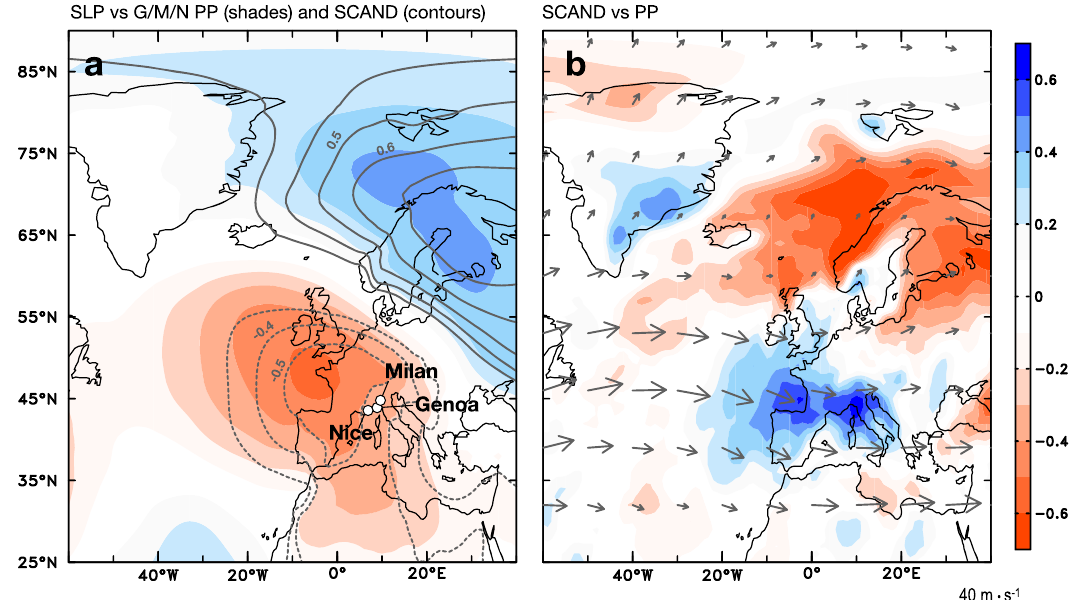
Fig. 1 | Climate and Atlantic sea-level pressure (SLP) variability. a Correlation between SLP and (i) average precipitation at Genoa, Milan and Nice stations (G/M/N PP) (shades); (ii) Climate Prediction Center (CPC) Scandinavia index (SCAND) (contours) during September – February in 1950 – 2008 C.E. b Vectors: climatological winds at 200-mb level plus regression of 200-mb winds on SCAND